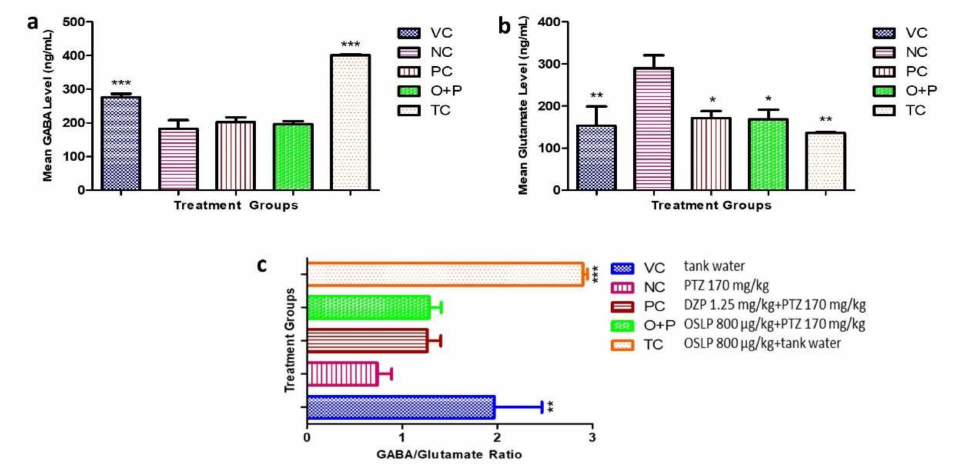
Figure 7. Mean neurotransmitter levels (ng / mL), namely GABA ( a ), glutamate ( b ) and GABA / Glu ratio ( c ) over 600 s for all the experimental groups. The data are expressed as Mean ± SEM, n = 10 and was analyzed using One-way ANOVA followed with Dunnett’s post-hoc test at significance level of * p < 0.05, ** p < 0.01 and *** p < 0.001 against the negative control group (NC, PTZ 170 mg / kg). VC (tank water, i.p.), PC (DZP 1.25 mg / kg + PTZ 170 mg / kg, i.p.), O + P (OSLP 800 µ g / kg + PTZ 170 mg / kg, i.p.) and TC (OSLP 800 µ g / kg + tank water,